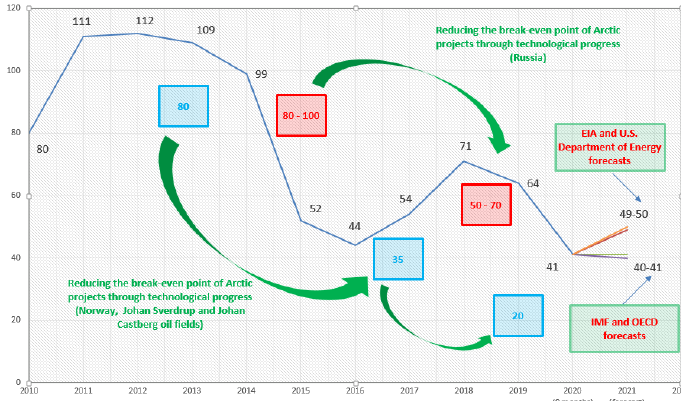
Figure 2. Changes in oil prices and the break-even point of offshore oil and gas projects in the Arc- tic. Source: Created by the authors, data from [6,43,49,55–62]. Source: Created by the authors, data from